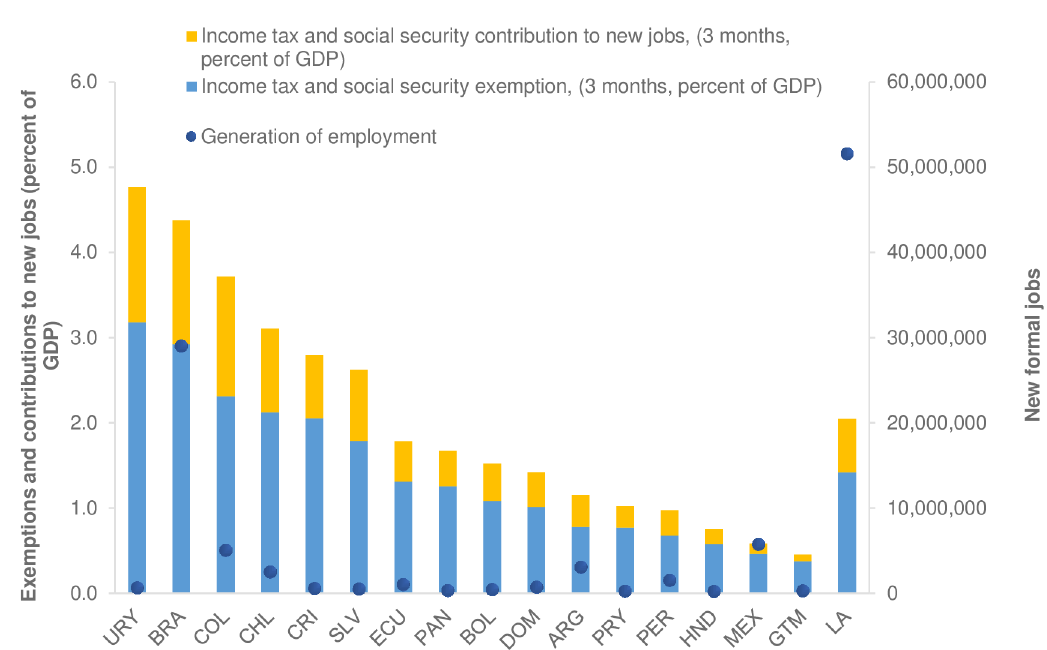
Fig 8. Latin America: Results of the simulation of interventions to cushion the impact of the increase in the informality rate. Source: Estimates from household or employment surveys: Argentina—EPH (2019), Bolivia—ECH (2018), Brazil—PNADC (2018), Chile—CASEN (2017), Colombia—GEIH (2018), Costa Rica—ENAHO (2018), Ecuador—ENEMDU (2018), El Salvador —EHPM (2019), Guatemala—ENEI (2018), Honduras—EPHPM—(2018), Mexico—ENIGH (2018), Panama—EPM (2017), Paraguay—EPHC (2018), Peru—ENAHO (2018), Dominican Republic ENCFT (2017), Uruguay—ECH (2019). The EPH survey in Argentina only has urban coverage.